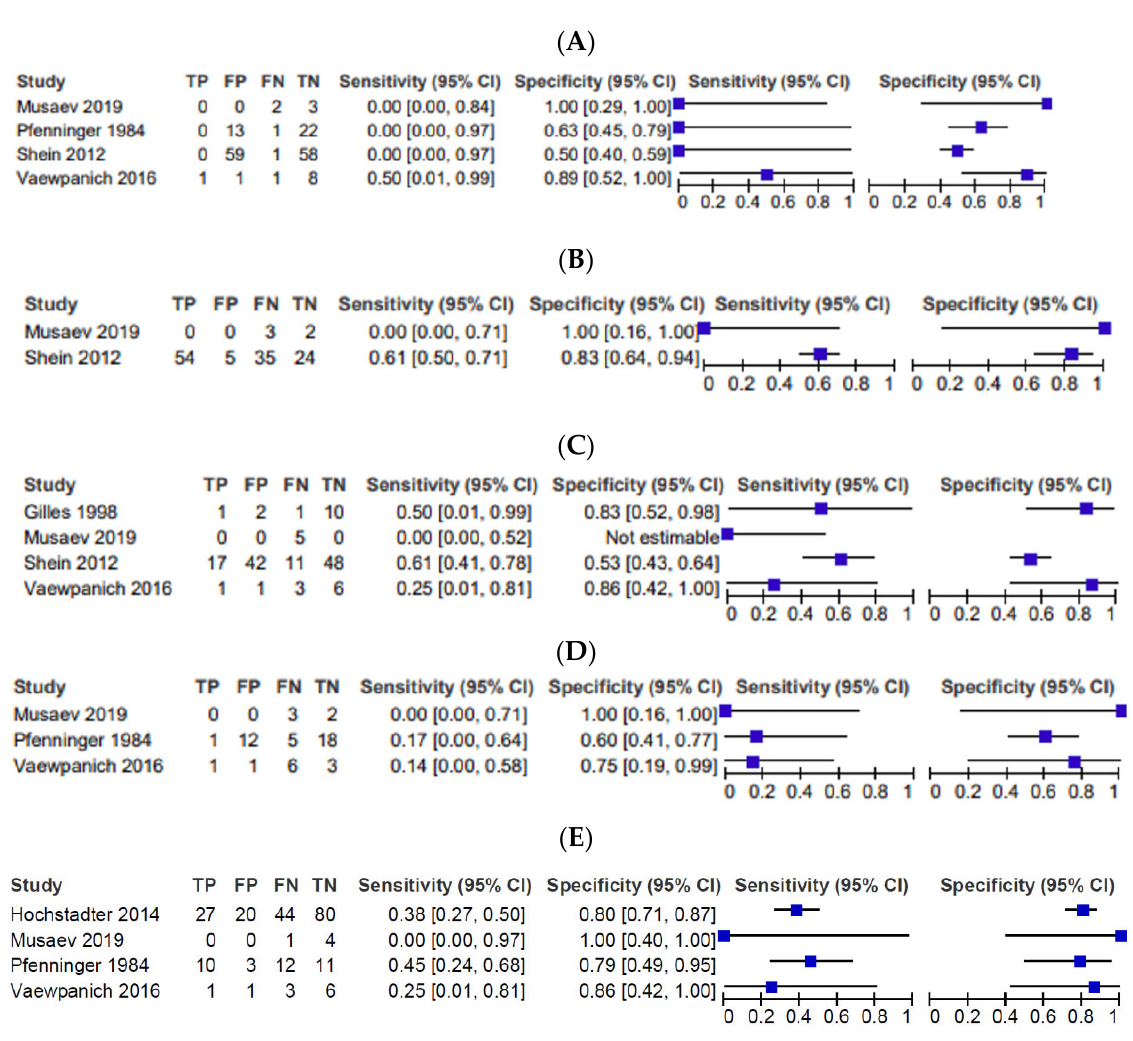
Figure 2. ROC for different parameters for diagnosis of death vs. survived. ( A ) ROC for EDH show ‐ ing the AUC of 0.52. ( B ) ROC for edema showing the AUC of 0.66. ( C ) ROC for skull fractures show ‐ ing the AUC of 0.53. ( D ) ROC for SDH showing the AUC of 0.62. ( E ) ROC for tSAH showing the AUC of 0.62.